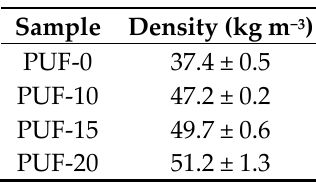
Table 2. Designation and density of obtained flexible polyurethane foams.